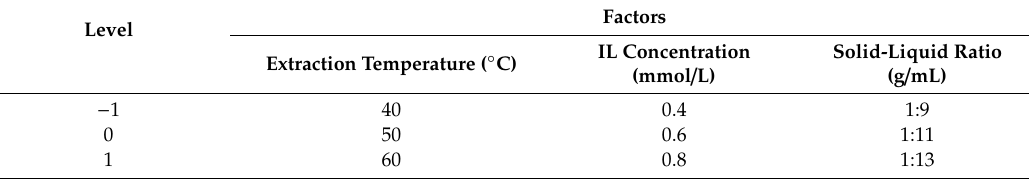
Table 6. Levels and codes of factors chosen for